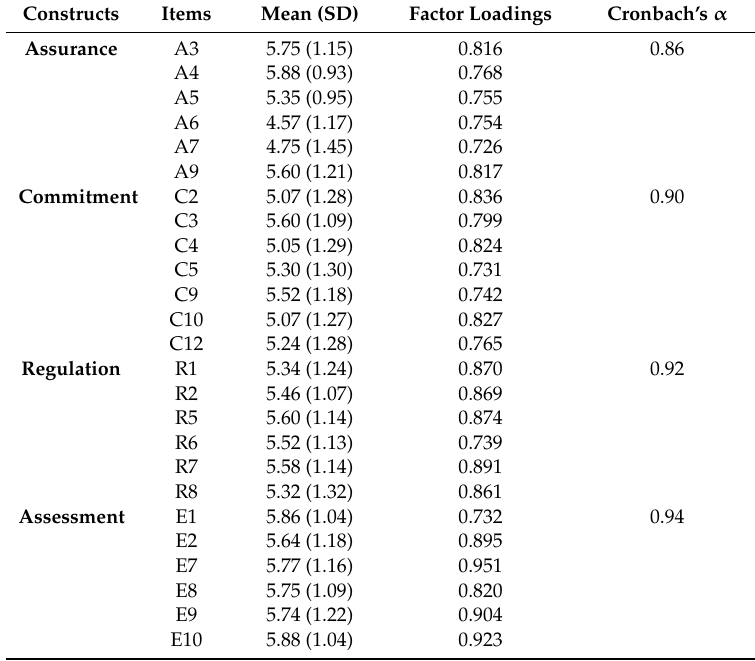
Table 6. FSG items and measurement